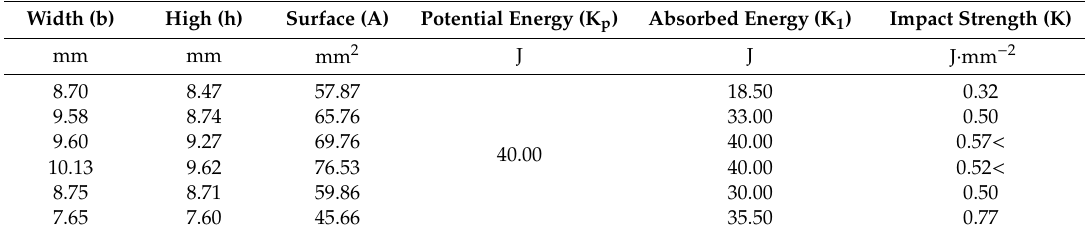
Table 7. Impact strength of Rosa multiflora